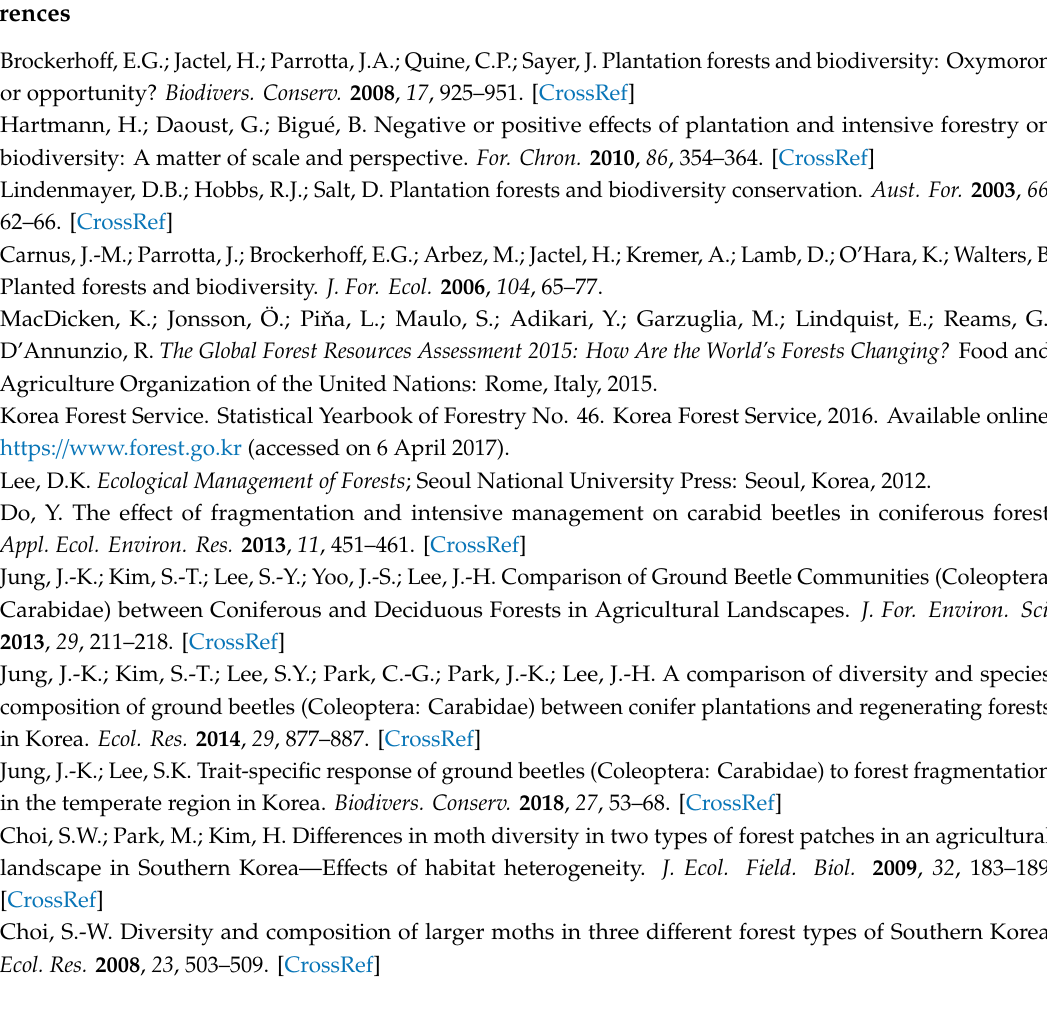
Table S1: List of carabid beetles with number of individuals in Pinus densiflora forests (PF) and broad-leaved deciduous forests (BLF) in central